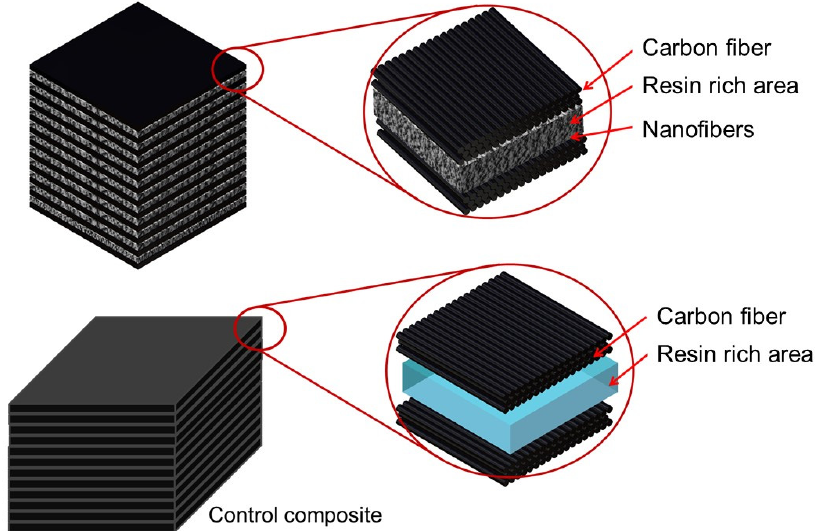
Figure 2. The schematic illustration of the hybrid and control composites